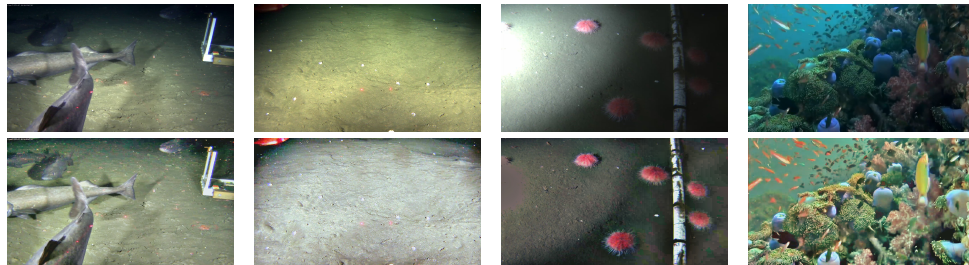
Figure 10. Three low-light examples on the left were chosen from the OceanDark dataset, and the other one was from the UIEB. Top row: images with unbalanced light; Bottom row: corresponding enhanced